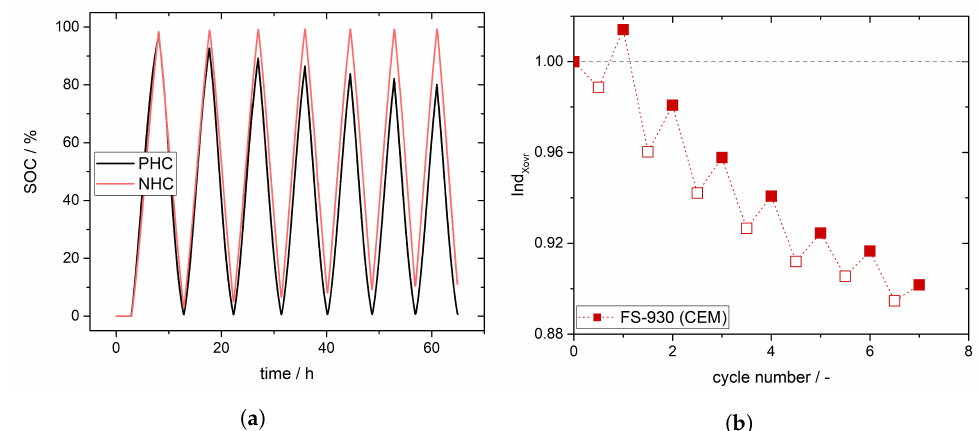
Figure 6. ( a ) State of charge (SOC) estimated from redox-potential measurements in the positive half-cell (PHC) and negative half-cell (NHC), battery cell with cation exchange membrane (FS-930), parameters for charge and discharge cycles in Table 1. ( b ) Resulting crossover index Ind Xovr for the SOC data in ( a ). According to cycle numbers full numbers display a discharge half-cycle (filled icons) and half numbers (x,5) display a charge half-cycle (empty icons).